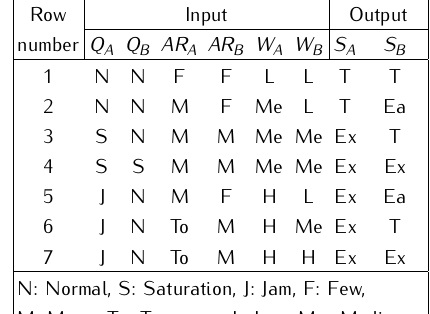
Figure 8. Block diagram proposed fuzzy model